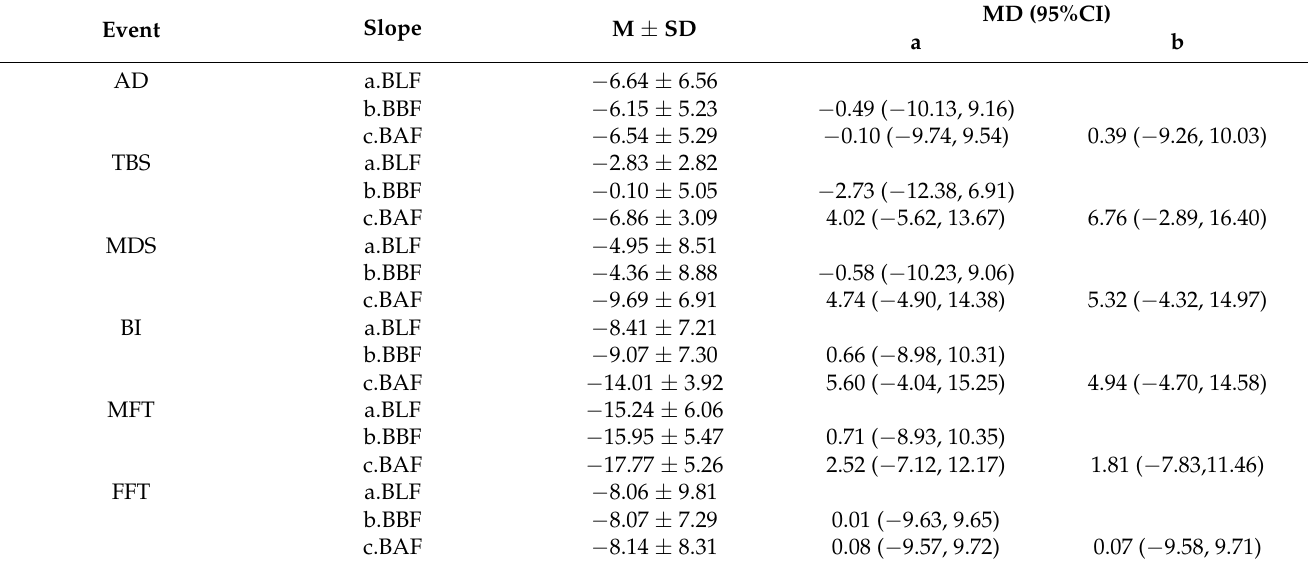
Table 5. Trunk angle in frontal results for the BLF, BBF, and BAF at different events.